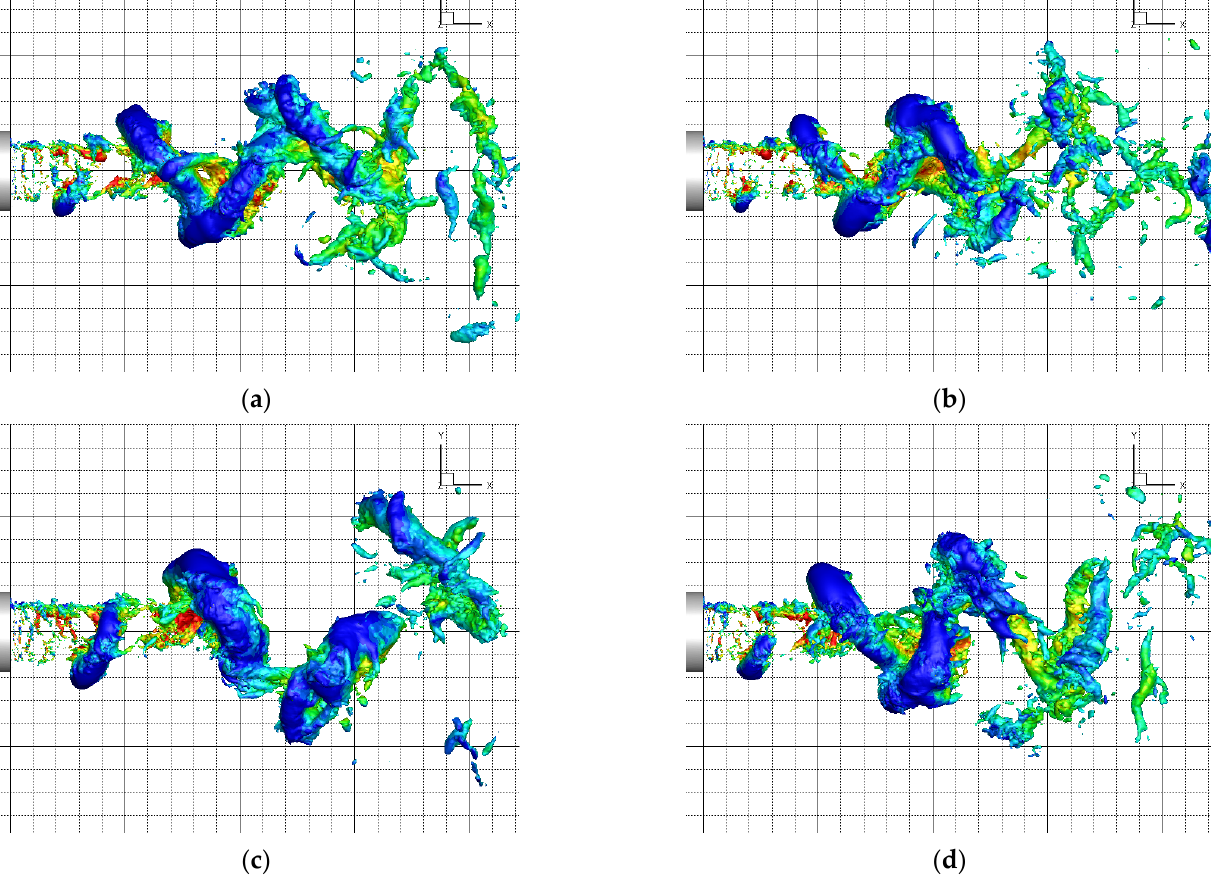
Figure 22. Coherent structures under different amplitudes and frequencies, visualized by the iso-surface of pressure and colored by the streamwise velocity magnitude, p / ρ U j 2 = − 0.05. ( a ) MFR = 0.67%, St D = 0.15, ( b ) MFR = 0.67%, St D = 0.2, ( c ) MFR = 0.83%, St D = 0.1, ( d ) MFR = 0.83%, St D = 0.15.